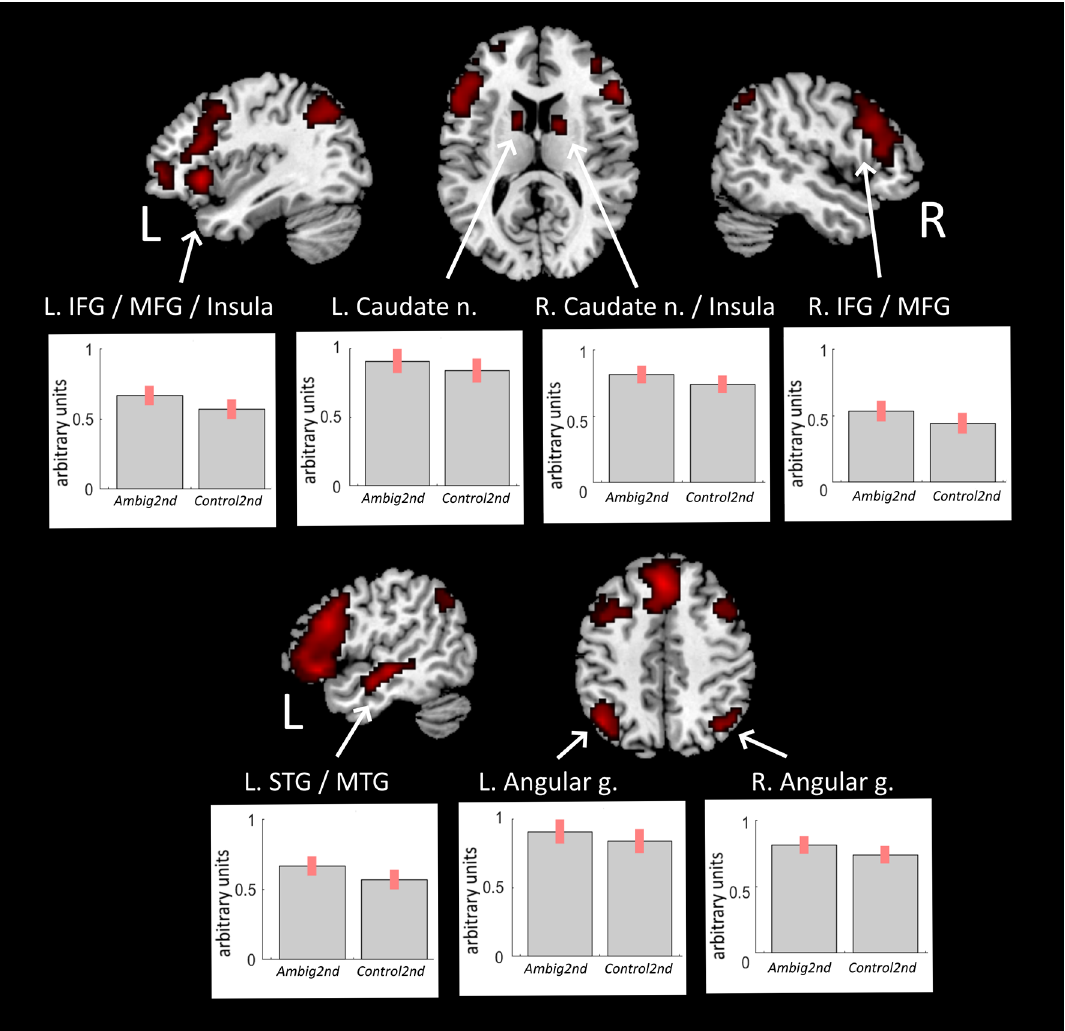
Figure 3. Enhanced BOLD signal associated with finding solution in Ambig2nd condition when fragmented noun having two solutions was paired with new fragmented adjective making previous solution to this nous inappropriate. Denotations: L/R left/right hemisphere, IFG inferior frontal gyrus, MFG middle frontal gyrus, STG superior temporal gyrus, MTG middle temporal gyrus, g . gyrus, n .